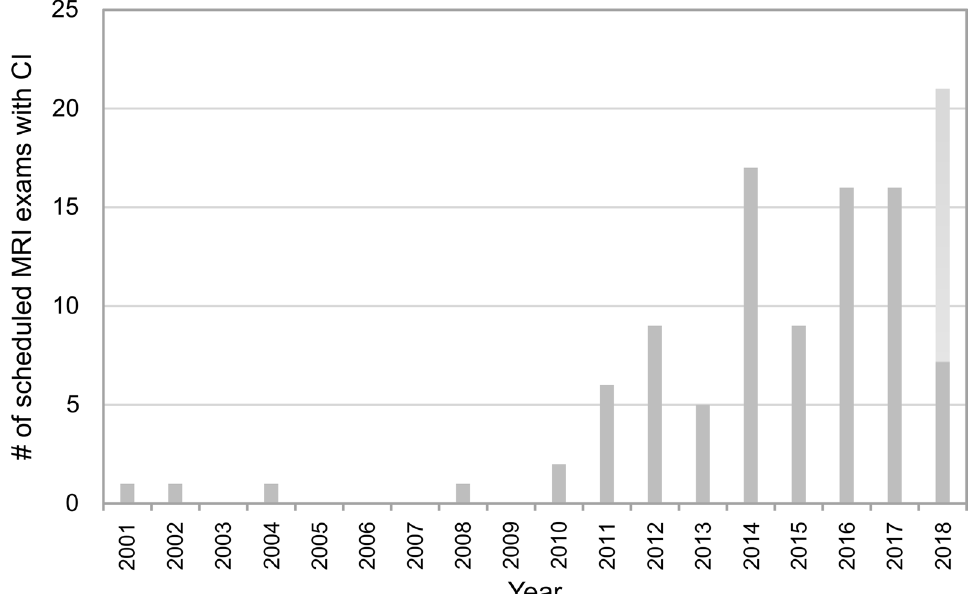
Fig. 1 Bar graph showing the number of scheduled MRI examinations with cochlea implant per year between 2001 and 2018 at a single tertiary center (three campuses). The stacked bar for 2018 shows both the actual number for the first 4 months (7, dark gray) and the extrapolated value (21, light gray) for the entire